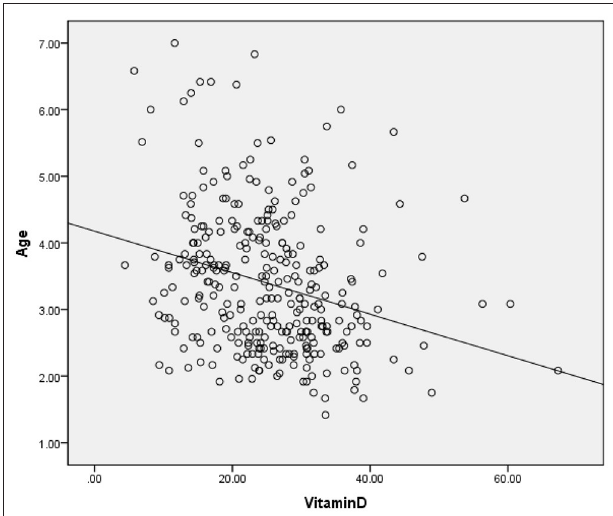
FIGURE 1 | Correlation of vitamin D (ng/ml) and age (y).